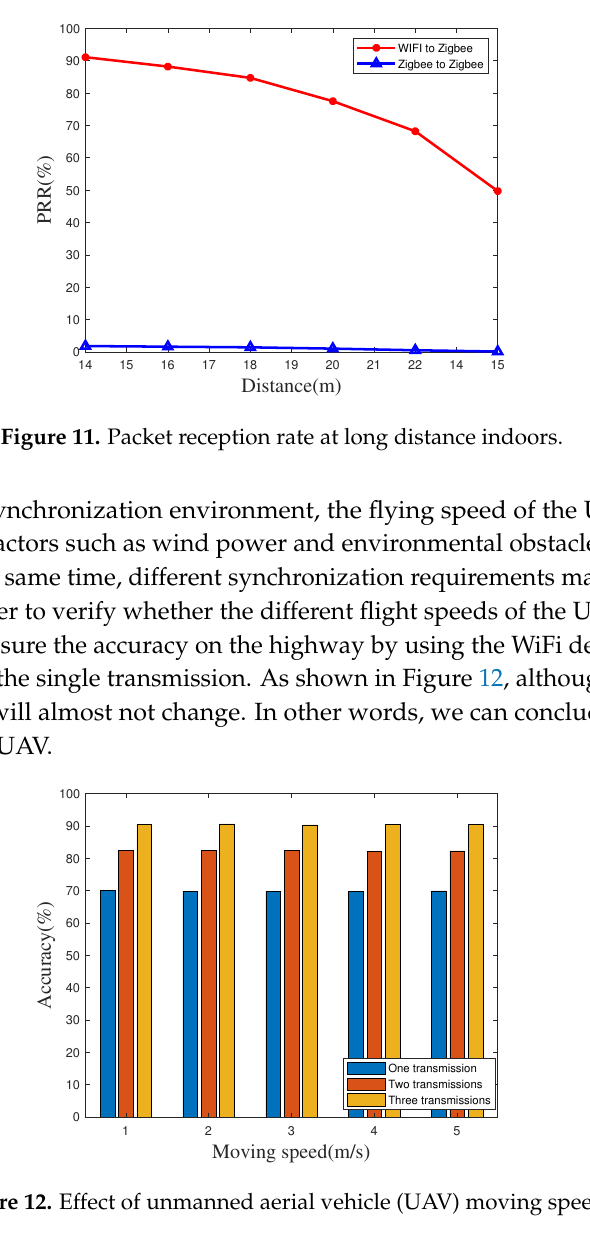
Figure 10. Packet reception rate at short distance indoors.